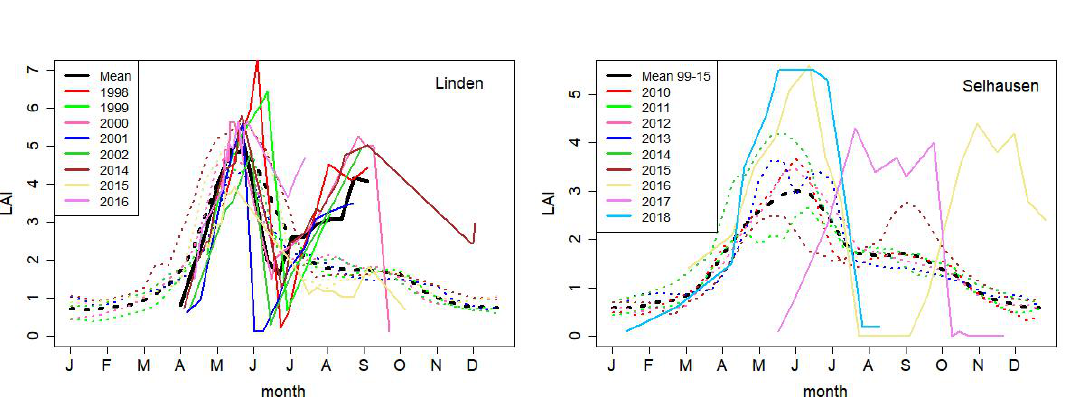
Figure 2. Leaf area index (LAI) satellite (dotted) and in-situ (solid lines) observations at Linden and Selhausen for the years shown in the legend on the left in different colors. In-situ measurements are only available for the given years and dates. At Linden, the shown simulated years are (except 1998) the same as the in-situ observations. At Selhausen, the six years of simulations before the in-situ observations are shown. The mean annual cycle of the satellite LAI for the given years is shown in black